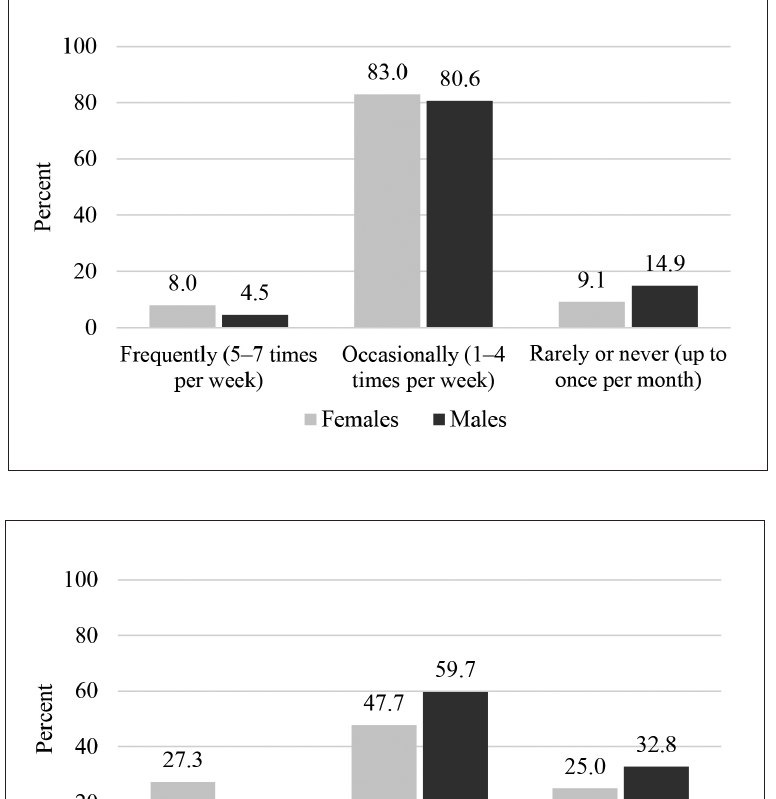
Figure 4. Fruit and vegetable consumption